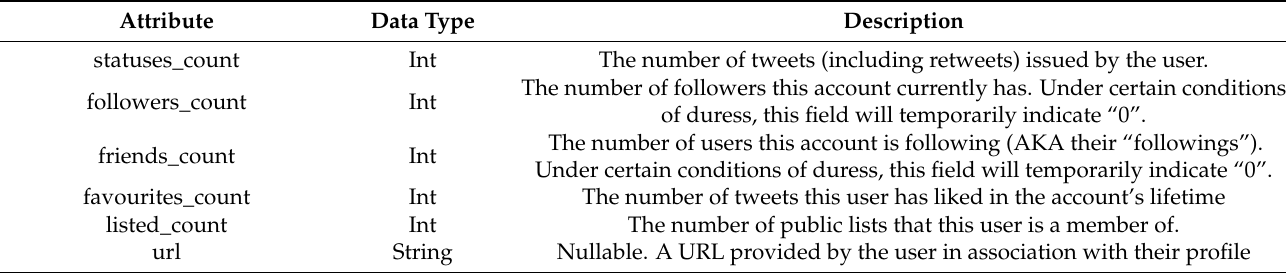
Table 2. The feature selections formulated for the